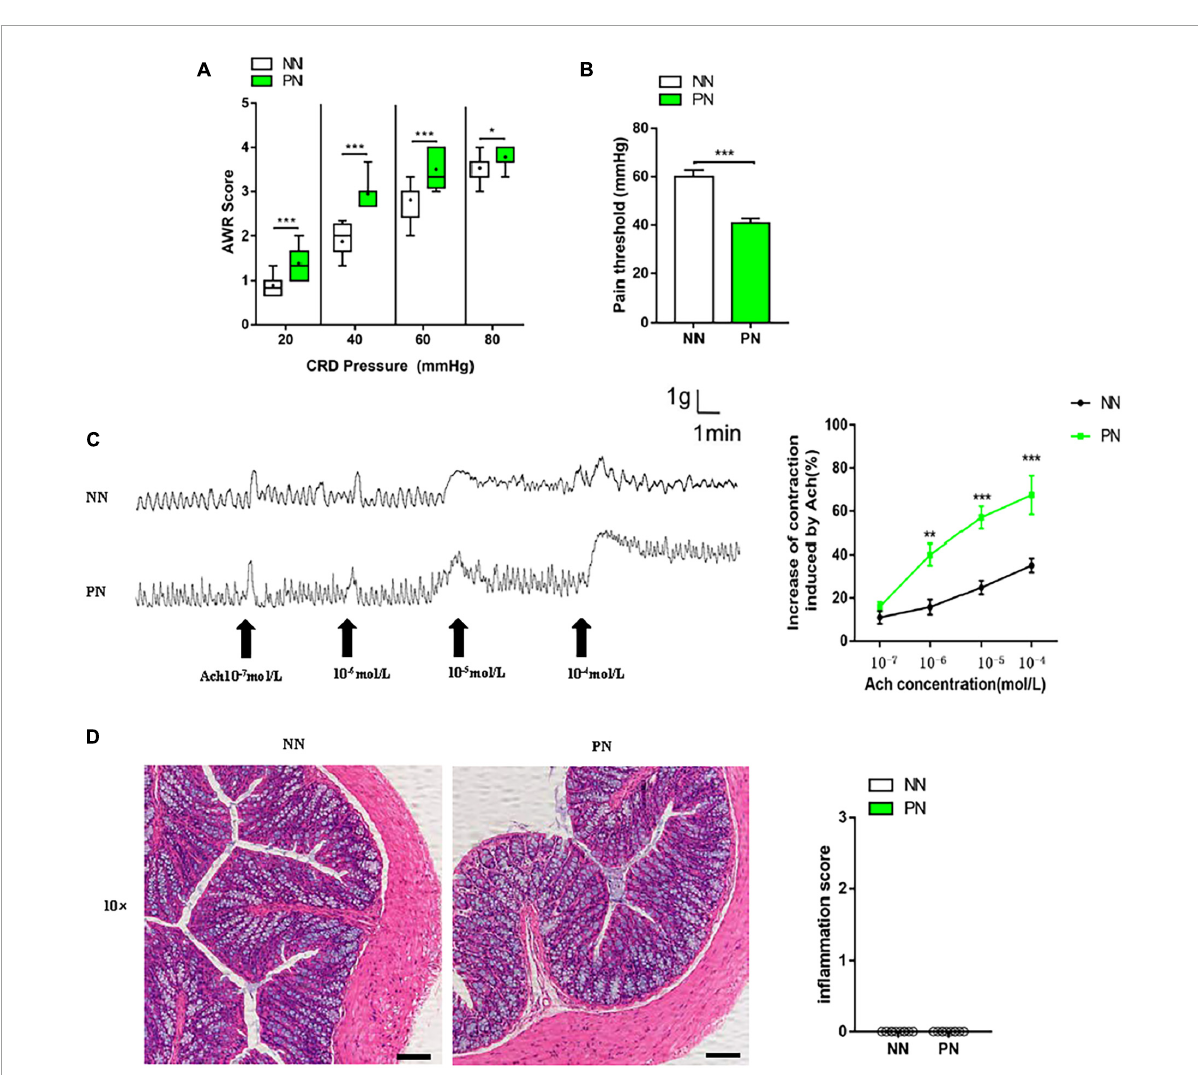
FIGURE2 Light/dark phase shift increases visceral sensitivity without microscopic inflammation in mice. (A) AWR scores under each CRD pressure. n = 12 per group. Data are presented as medians and 25th to 75th interquartile ranges. (B) Pain threshold. n = 12 per group. (C) Contraction curve of colonic muscle strips to Ach and increase in AUC under different Ach concentrations of the NN and PN groups (compared to baseline), n = 6 per group. (D) HE staining of colon and inflammation score under microscopic observation. Scale bar, 100 µ m. n = 5 per group. Data are expressed as the mean ± SEM. Comparison between two groups performed with a two-tail Student’s t -test. * P < 0.05, ** P < 0.01, *** P < 0.001. NN, Non-phase shift; PN, Phase shift; AWR, Abdominal withdrawal reflex; CRD, Colorectal distension; Ach, Acetylcholine; HE, Hematoxylin-eosin